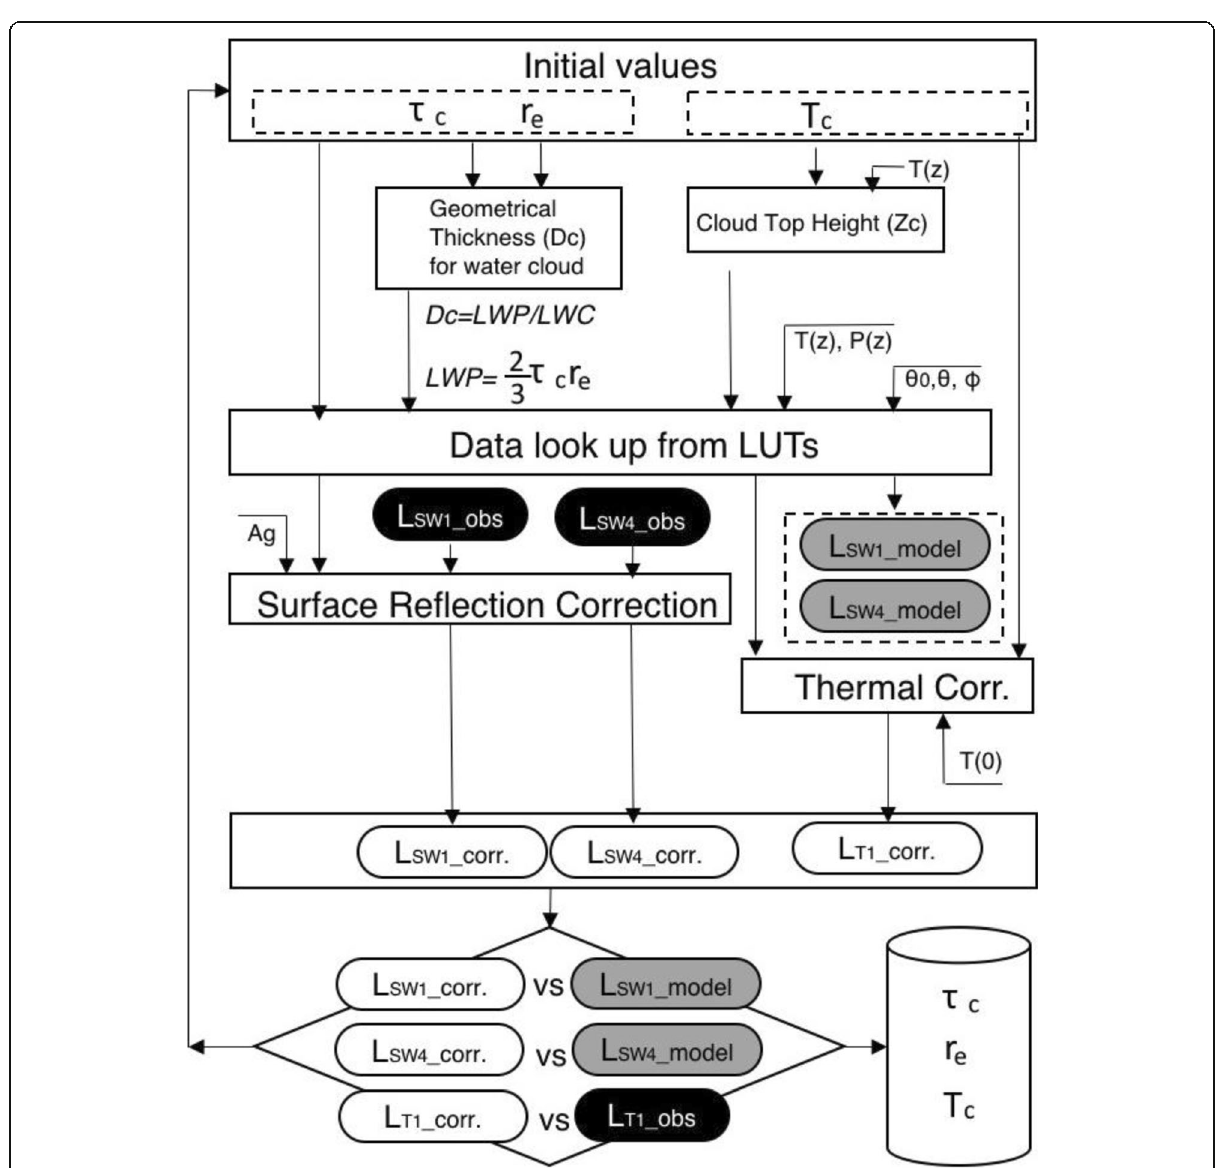
Fig. 8 Flow chart of the CAPCOM algorithm. “ _corr. ” denotes correction. LWP and LWC denote liquid water path and liquid water content, respectively. Warm water clouds are